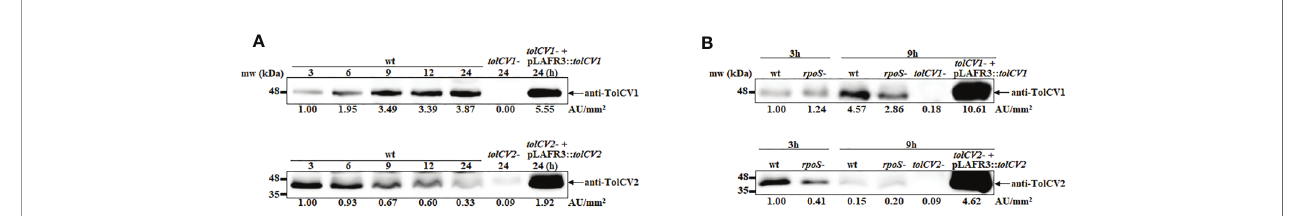
FIGURE 1 | Effect of rpoS mutation on the expression of outer membrane proteins TolCV1 and TolCV2. Overnight cultures of each V. vulni fi cus strains were diluted 200-fold with fresh LB broth and grown in a 37°C shaking incubator. Equivalent number of bacterial cells (2×10 8 CFU) were harvested at indicated time points followed by Western blotting with anti-TolCV1 or anti-TolCV2 primary antibodies. (A) Western blot analysis of V. vulni fi cus wild-type cells harvested at 3, 6, 9, 12, and 24 h cultures (B) Western blot analysis of V. vulni fi cus wild-type and its rpoS mutant cells collected at 3 h and 9 h cultures. Relative protein levels were quanti fi ed using ImageJ software. Results are representative of at least three independent experiments. Abbreviation: wt, wild-type; tolCV1 -: tolCV1 mutant of MO6-24/O; tolCV1 - + pLAFR3:: tolCV1 : complementary strain of tolCV1 mutant; tolCV2 -: tolCV2 mutant of MO6-24/O; tolCV2 - + pLAFR3:: tolCV2 : complementary strain of tolCV2 mutant; rpoS -: rpoS mutant of